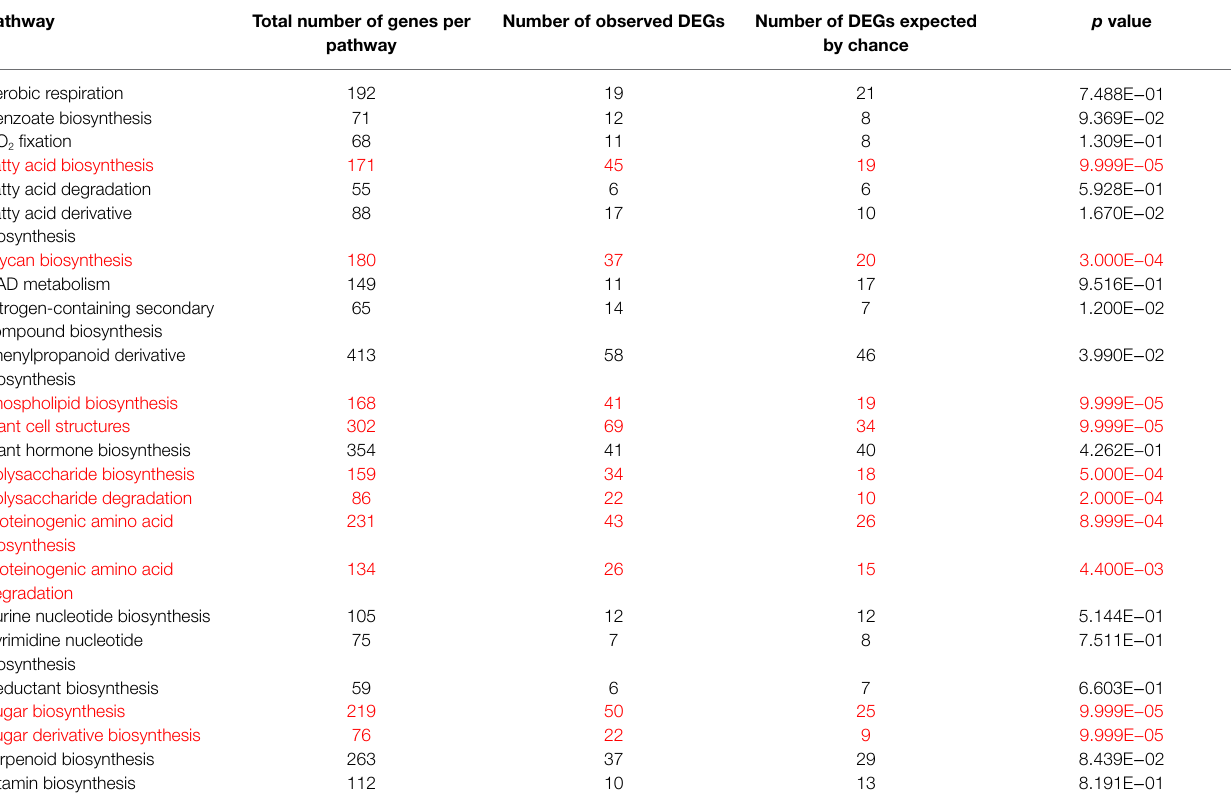
TABLE 2 | Permutation tests for the accumulation of flowering-associated DEGs in different metabolic pathways.